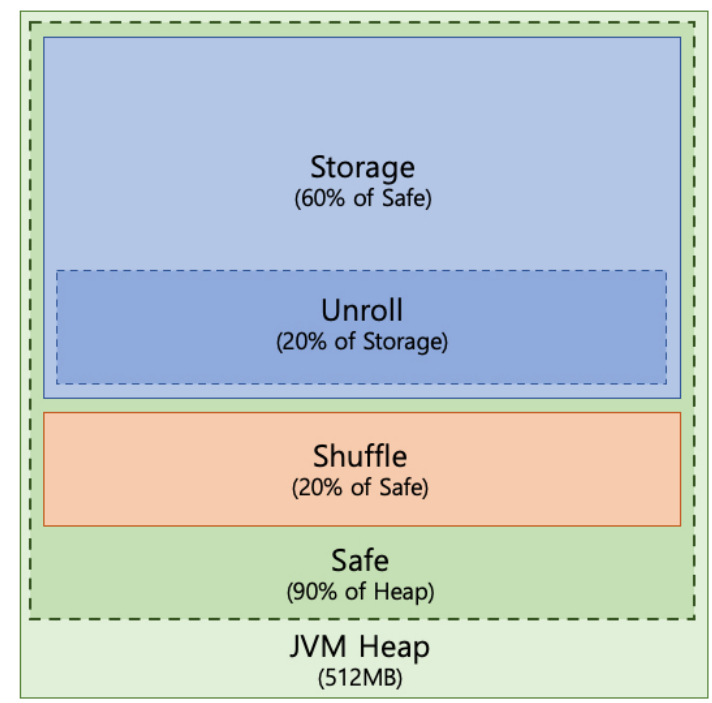
Figure 2. Spark JVM